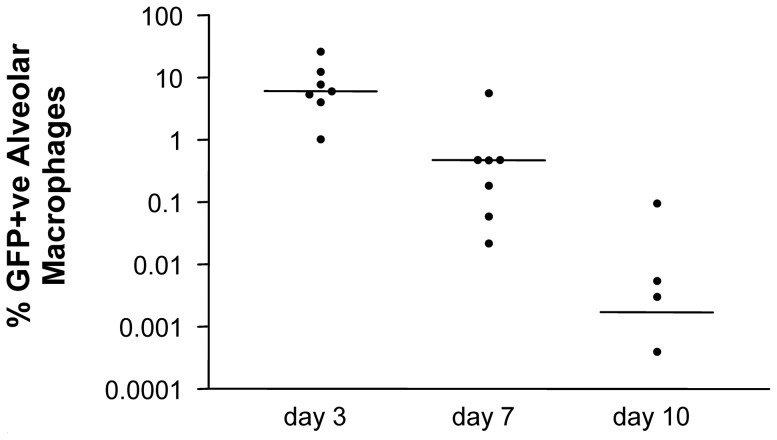
Transgene expression in alveolar macrophages is restricted to the segment infected with adenoviral vector.Alveolar macrophages were collected on day 3, 7 and 10 from sheep infected on day 0 with Ad-GFP/calcium phosphate from both segments infected with adenovirus and from naïve segments and assessed for GFP by UV microscopy after 24 hours in culture. Data is shown as scatter plots with the horizontal bars indicating the median. Macrophages from Ad-GFP infected segments on day 14 were negative for GFP. No GFP+ve macrophages were identified in BALF from any naïve segments at any time point (data not shown). NB Zero values are not shown due to the use of a log scale.